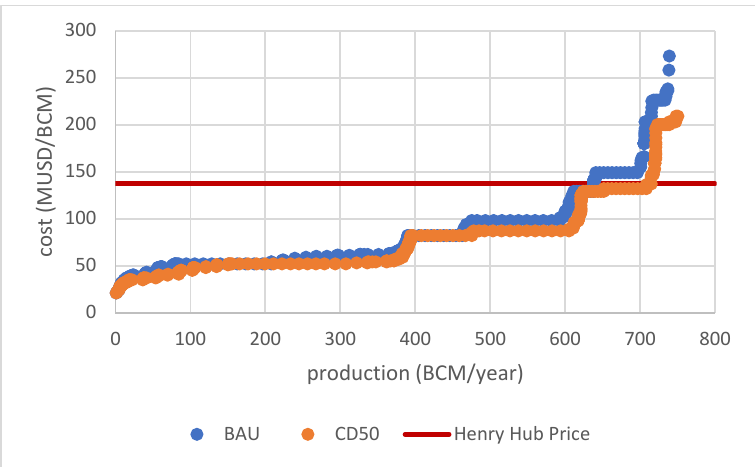
Figure 6. Breakeven price as a function of production volume.